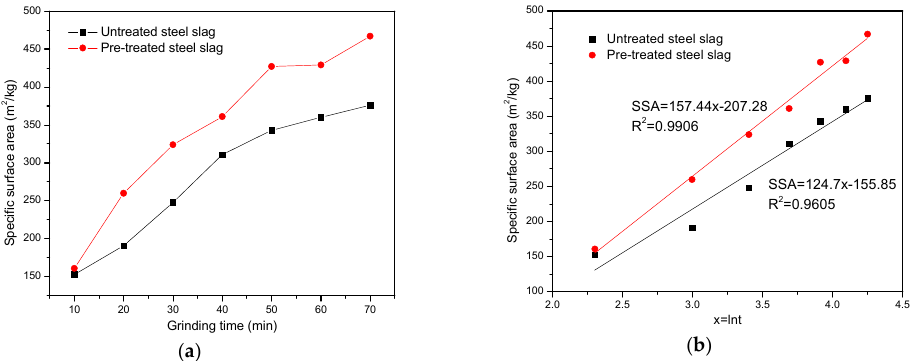
Figure 6. Specific surface areas (SSA) of steel slag under different grinding time: ( a ) SSA vs. grinding time; ( b ) linear fitting of SSA.